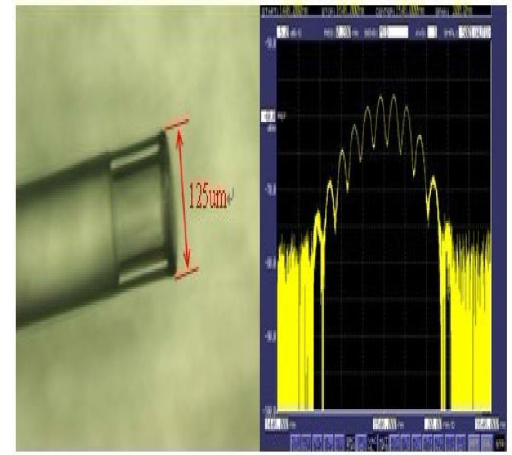
Fig. 2 Optical fiber F-P sensor probe and spectrum.